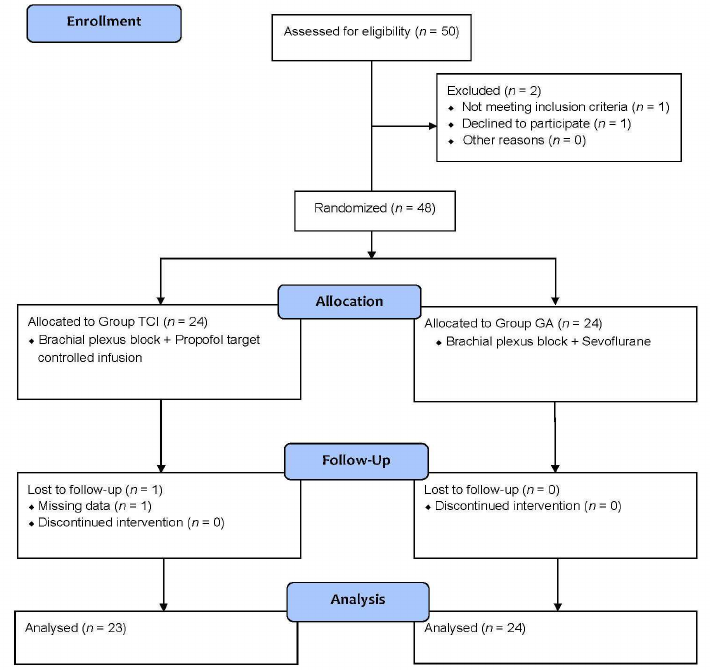
Figure 1. Subject enrollment flowchart. TCI = Propofol target-controlled infusion. GA = Gen- eral anesthesia. Table 1. Patient